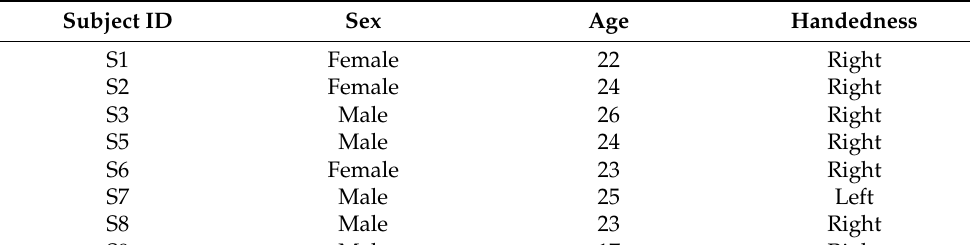
Table 2. Sociodemographic information is displayed for the subjects with SAQ scores, (age in years, SAQ mean ± standard deviation SD).